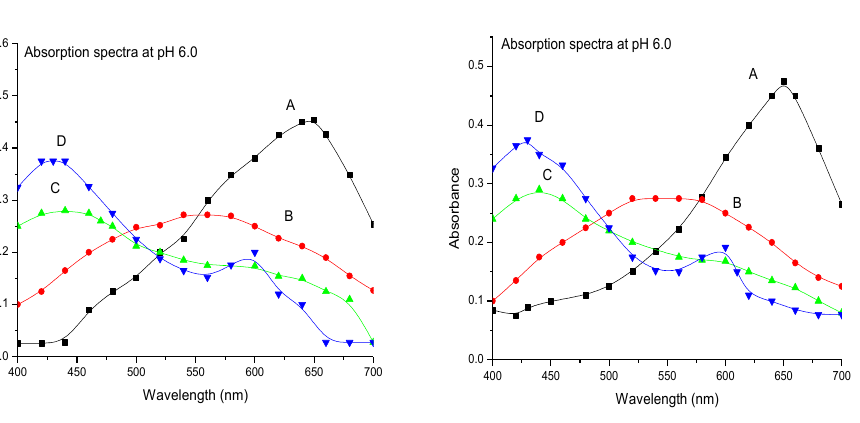
Figure 4. Absorption spectra of Nd at pH 6.0, A- ECAB-CDMEAB-Nd-(Ternary complex). B- ECAB-Nd at(pH 6.0)-(Binary complex), C -ECAB-CDMEAB-(Modified reagent), D